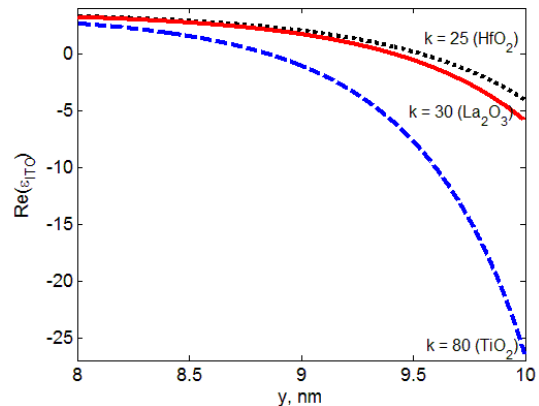
Figure 19: Depending on the insulating material, permittivity of TCO in the accumulation layer varies significantly. Extremely high values can be reached using strontium titanate. Similar to Figure 7, data calculated for 2.5 V applied on per 5 nm thick HfO 2 , La 2 O 3 , TiO 2 , or SrTiO 3 layer, and 10 19 cm −3 initial concentration in the 10-nm ITO film. TCO: Transparent conducting